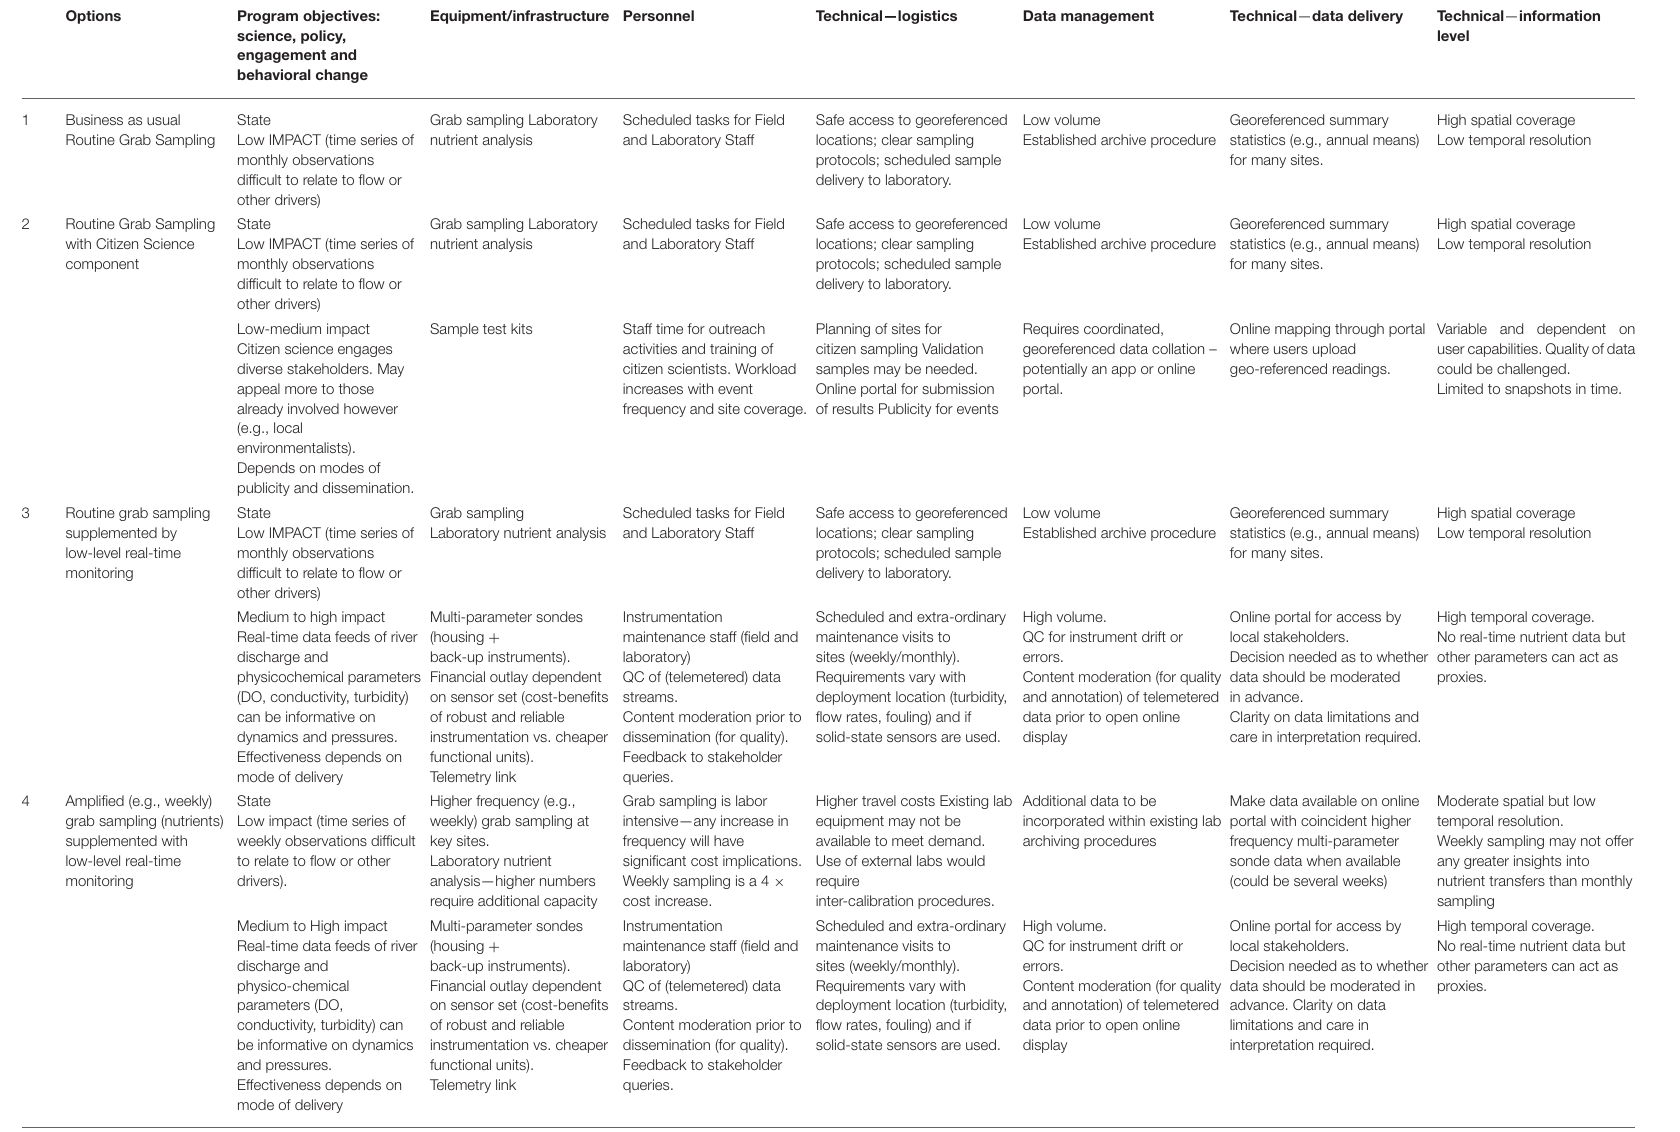
TABLE 2 | Options matrix for enhanced water quality monitoring compared against a business as usual